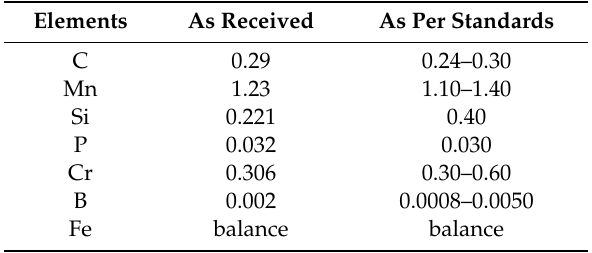
Table 1. Chemical composition of boron steel (30MnCrB4) in weight